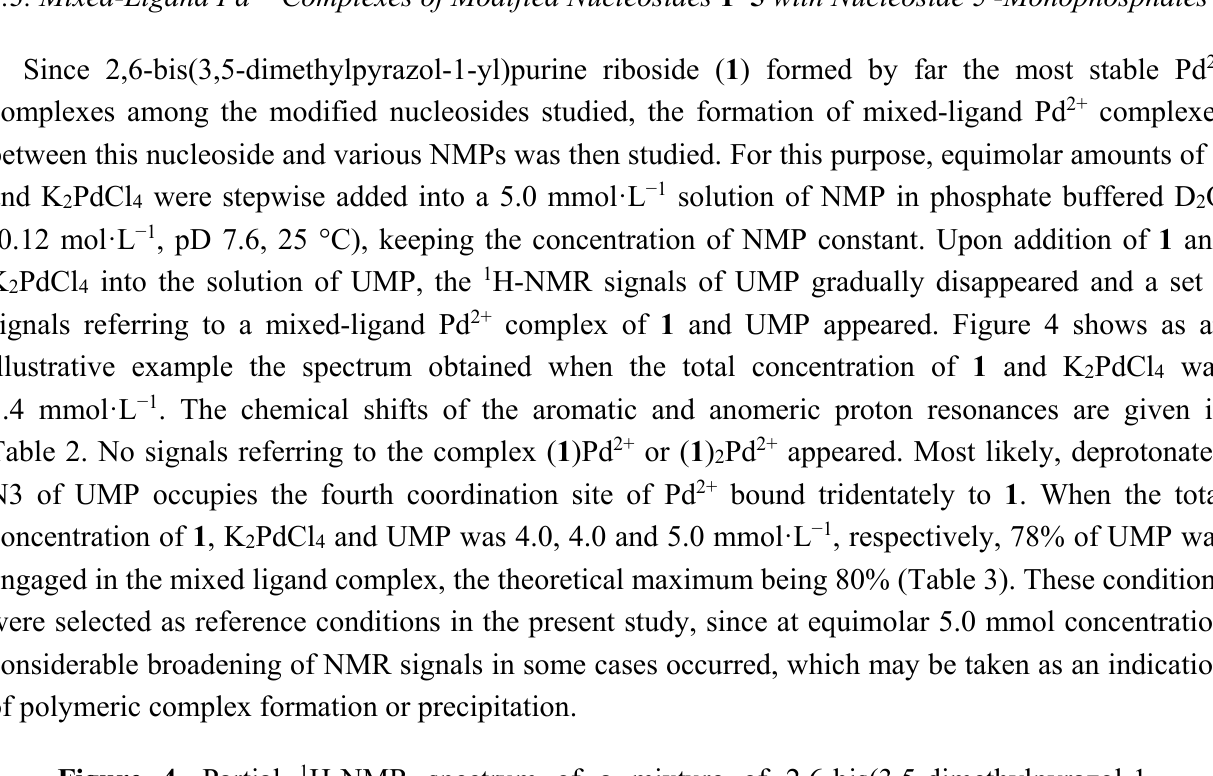
Figure 4. Partial 1 H-NMR spectrum of a mixture of 2,6-bis(3,5-dimethylpyrazol-1- yl)purine riboside ( 1 ; 3.4 mmol·L − 1 ), K 2 PdCl 4 (3.4 mmo·L − 1 ) and UMP (5.0 mmol·L − 1 ) in D 2 O (phosphate buffer 0.12 mol·L − 1 , pD 7.6, 25 °C). The doublet at 8.00 and